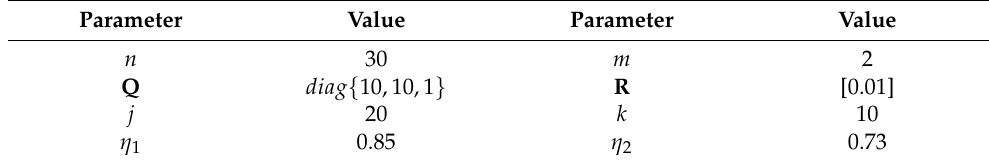
Table 2. Parameters of the controllers.